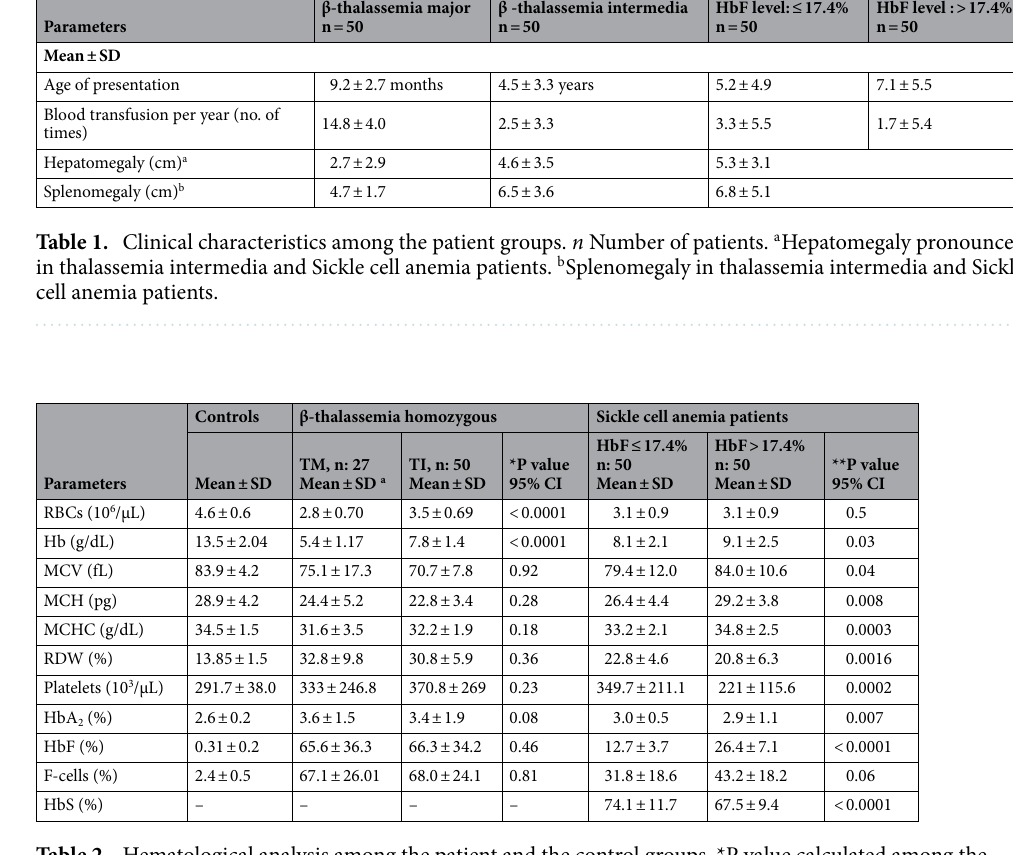
Table 2. Hematological analysis among the patient and the control groups. *P value calculated among the β-thalassemia homozygous groups, **P value calculated among the SCA patient groups. The P value was calculated using unpaired non parametric Mann–Whitney U test. a At the time of testing 23 TM patients were on regular transfusions, hence these patients were excluded from hematological analysis.